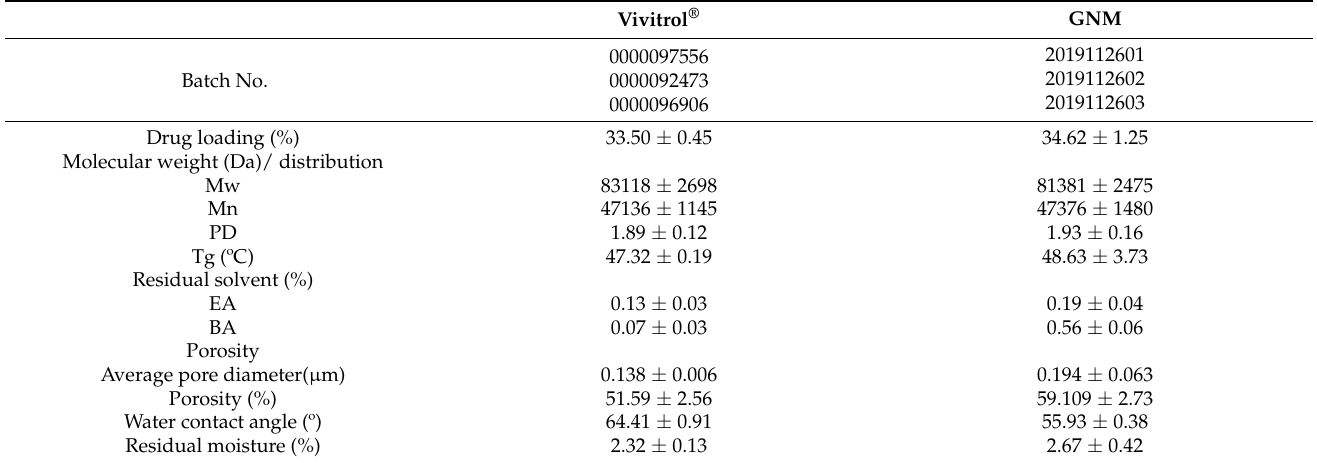
Table 1. Characteristics of Vivitrol ® and a generic naltrexone-loaded microsphere (GNM). Vivitrol ® GNM Batch